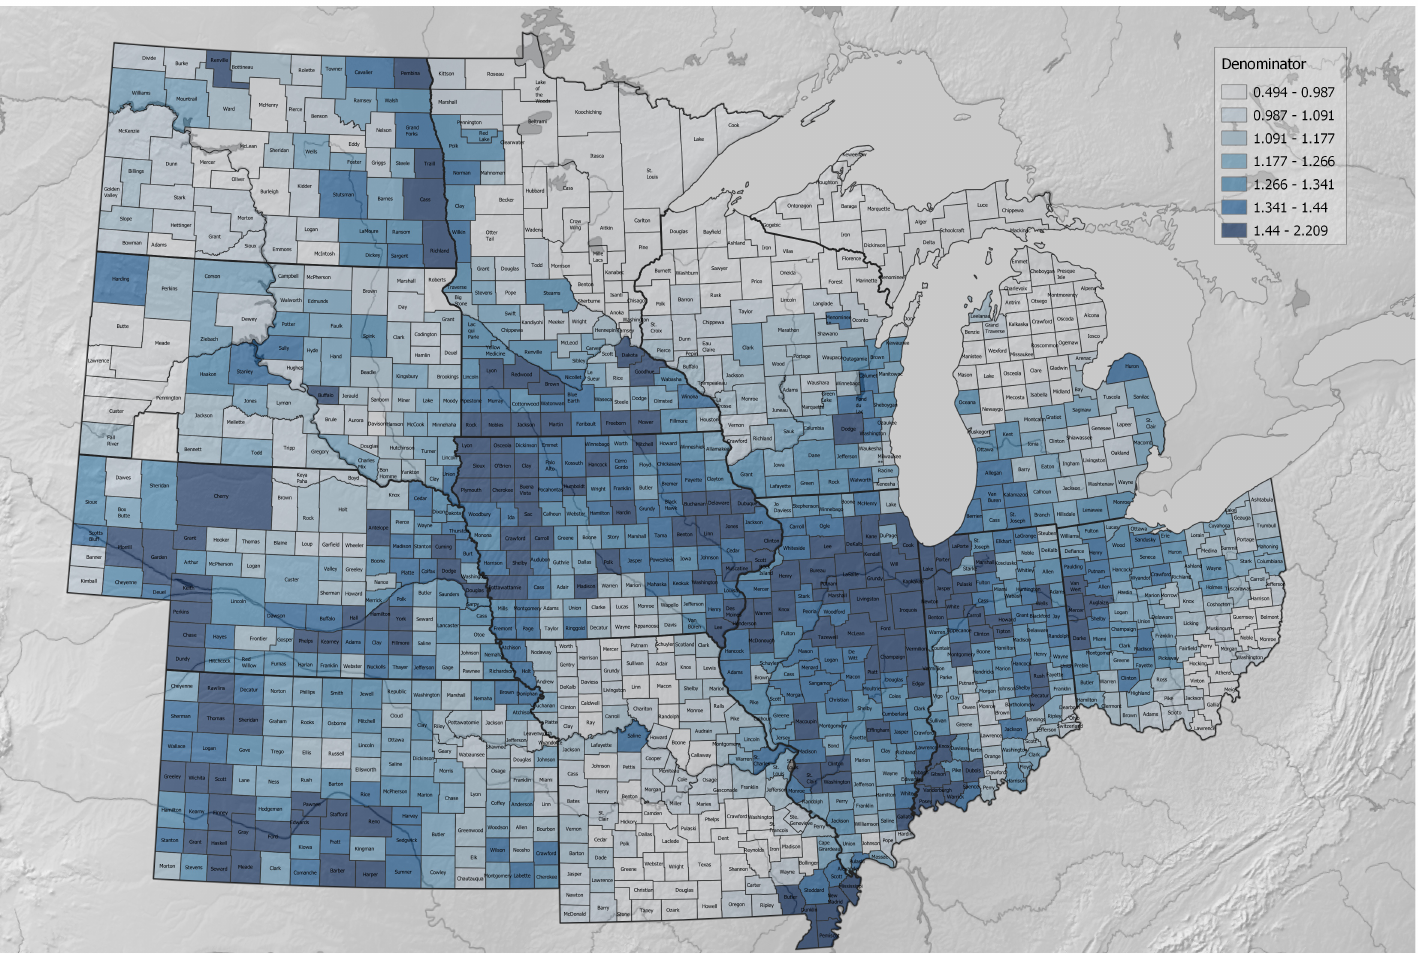
Figure 2. Regenerative–conventional agricultural index ratio denominator—the sum of variables we associated positively with conventional agricultural